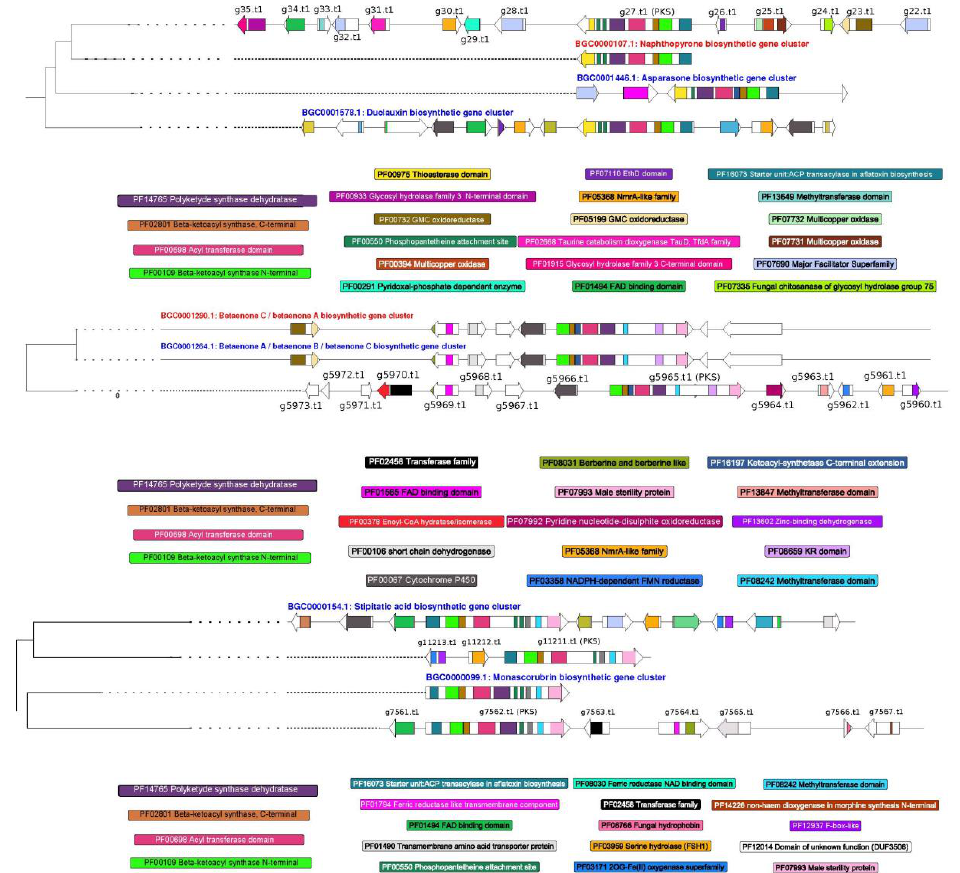
Figure 5. Polyketide synthases ( PKS ) genes in T. lixii MUT3171: Graphical representation of three PKS gene clusters found in T. lixii MUT3171 showing similarities with naphthopyrone, betaenones, stipitatic acid, and monoascorubrin biosynthetic gene clusters provided by the MIBig repository. For MUT3171 genes were reported.